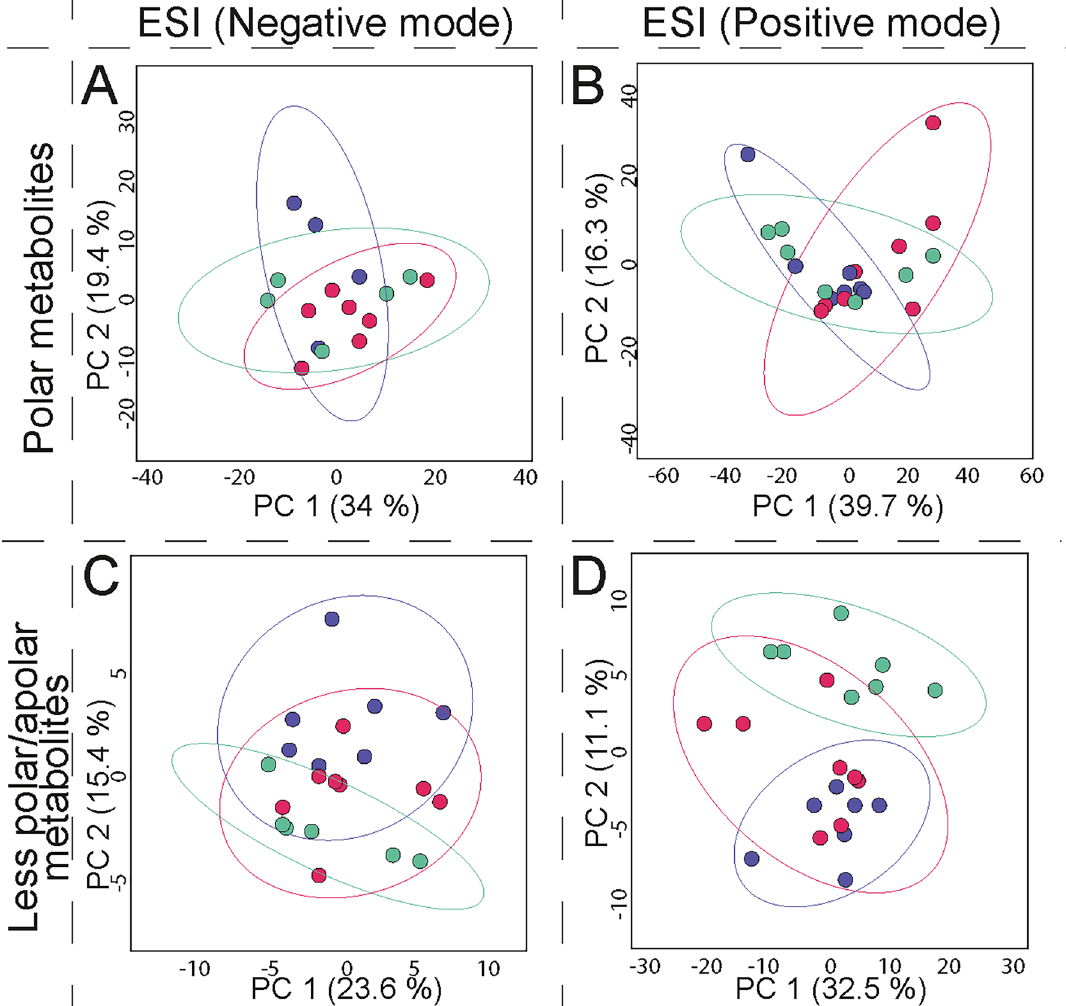
Figure 5. Principal component analysis for untargeted metabolomic tests using cortical bone (CB) from different human skeletal elements. Score plots for metabolites extracted and measured through HF-UPLC- IM-TOF-HRMS from cortical bone of femora, humeri, and tibiae of disarticulated human osteoarchaeological remains. Data matrices were subject to data cleaning, normalized, transformed, and scaled (see Materials and Methods section). ( A ) Polar metabolites (HILIC, ESI negative mode), N = 27, 471 variables; ( B ) Polar metabolites (HILIC, ESI positive mode), N = 28, 1629 variables; ( C ) Less-polar/apolar metabolites (C18, ESI negative mode), N = 27, 154 variables; ( D ) Less- polar/apolar metabolites (C18, ESI positive mode), N = 28, 665 variables. Ellipses indicate 95% of confidence for each group. The explained variances of selected principal components are shown in brackets. Observations are coloured according to each skeletal element: femur, red; humerus, green; tibia,